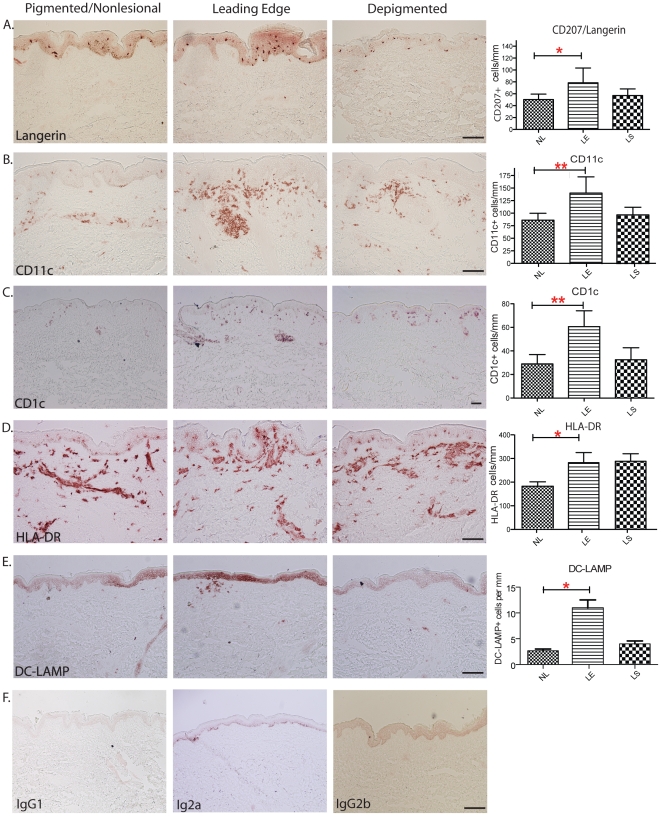
Characterization of Langerhans cells, dermal dendritic cells
subpopulations in matched non-lesional, leading edge and depigmented
lesional skin.Quantification of each cell population per mm of skin appears on the
right side of the micrograph image panels. Representative
immunohistochemical staining on non-lesional, leading edge and
depigmented lesional skin of (A) CD207/Langerin: Langerhans cell marker;
(B) CD11c: myeloid dermal dendritic cell marker; (C) CD1c/BDCA-1:
resident dermal dendritic cell marker; (D) HLA-DR: Activated Langerhans
cell and mature dermal DC marker. (E) DC-LAMP: mature DC marker. (F)
Mouse IgG1, IgG2a, and IgG2b were applied at the same concentrations as
the matching primaries antibodies on leading edge vitiligo skin.
Bar = 100 mm, applies to 2A, B, C, D&E.